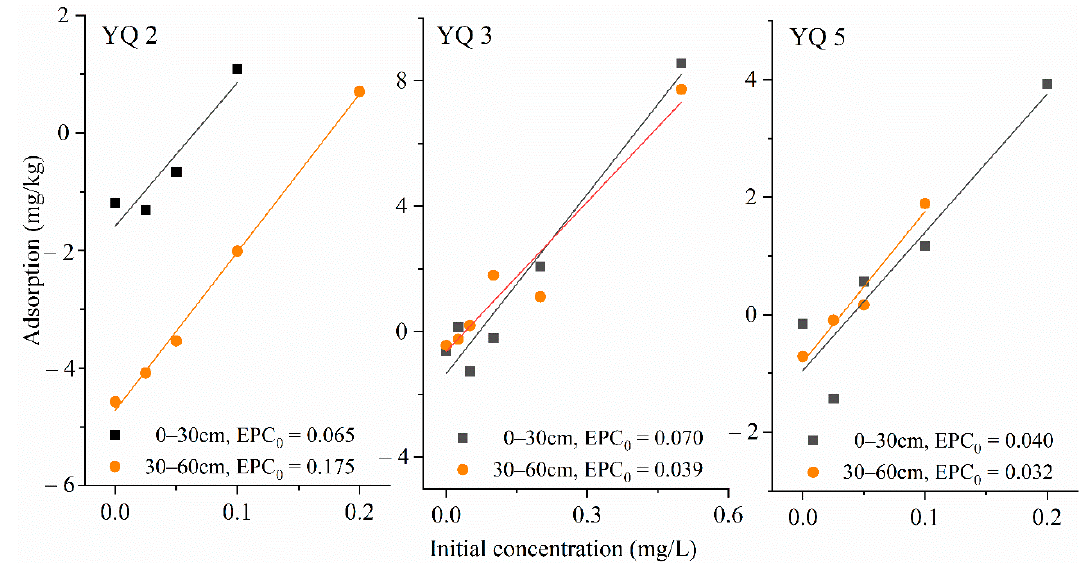
Figure 5. Phosphorus adsorption isotherms in sediment cores at two different sediment depths. Please note different scales on the Y–axis.